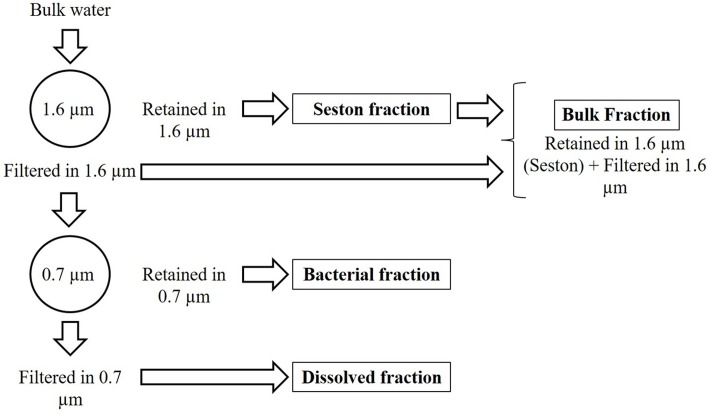
Scheme of the size fractionation of the water.